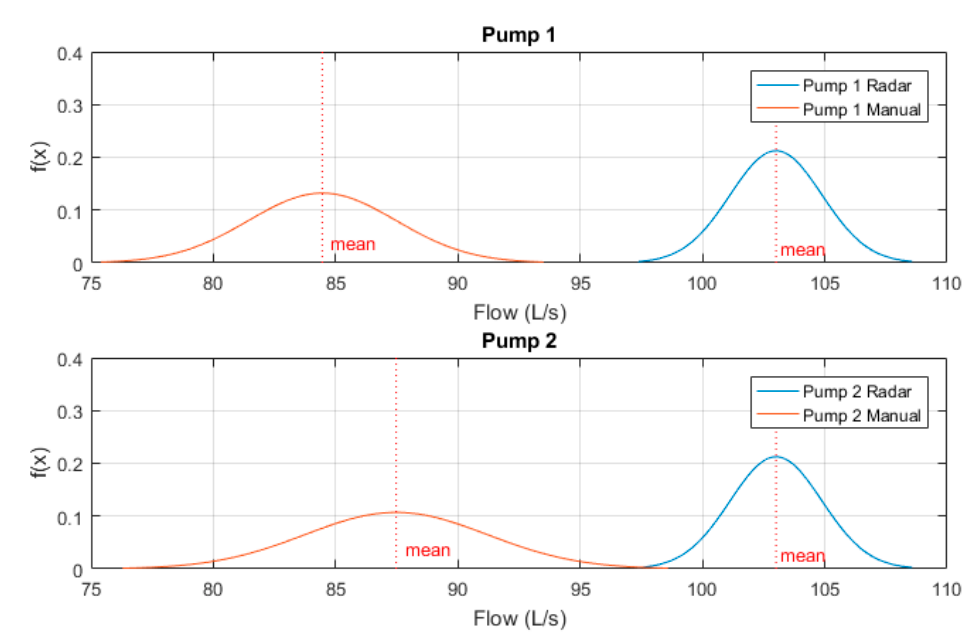
Figure 14. Site B normalised radar vs manual testing results.